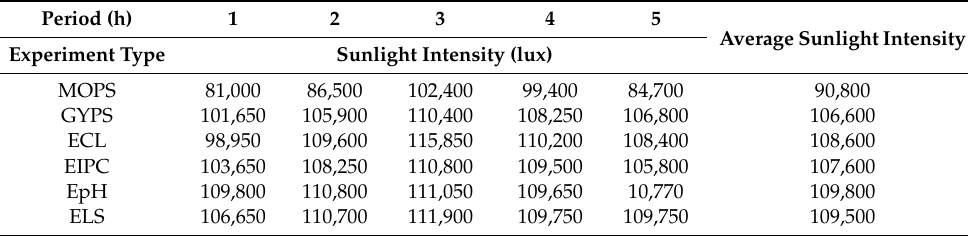
Table 2. Sunlight intensities recorded hourly over a five-hour period, for di ff erent experiments. Period (h) 1 2